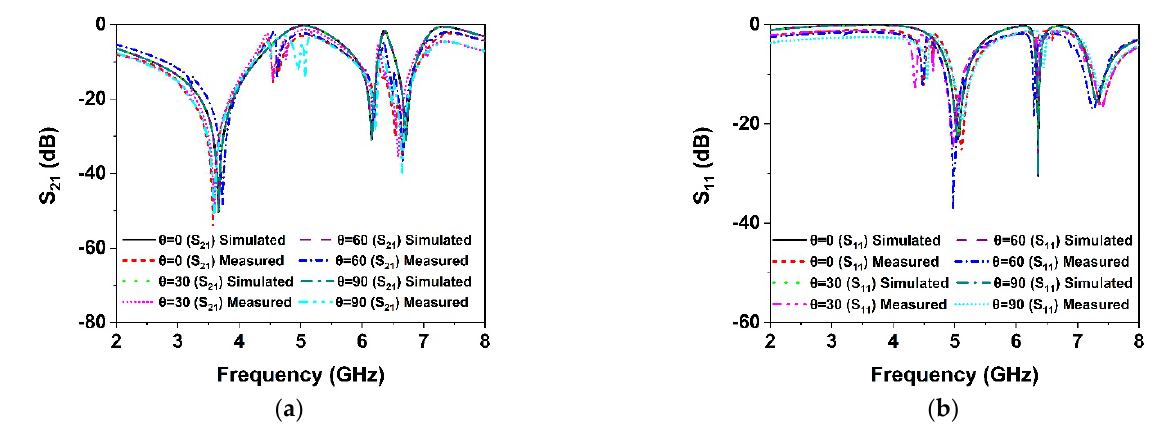
Figure 15. Incident angle insensitivity experimental results ( a ) S 21 and ( b ) S 11.